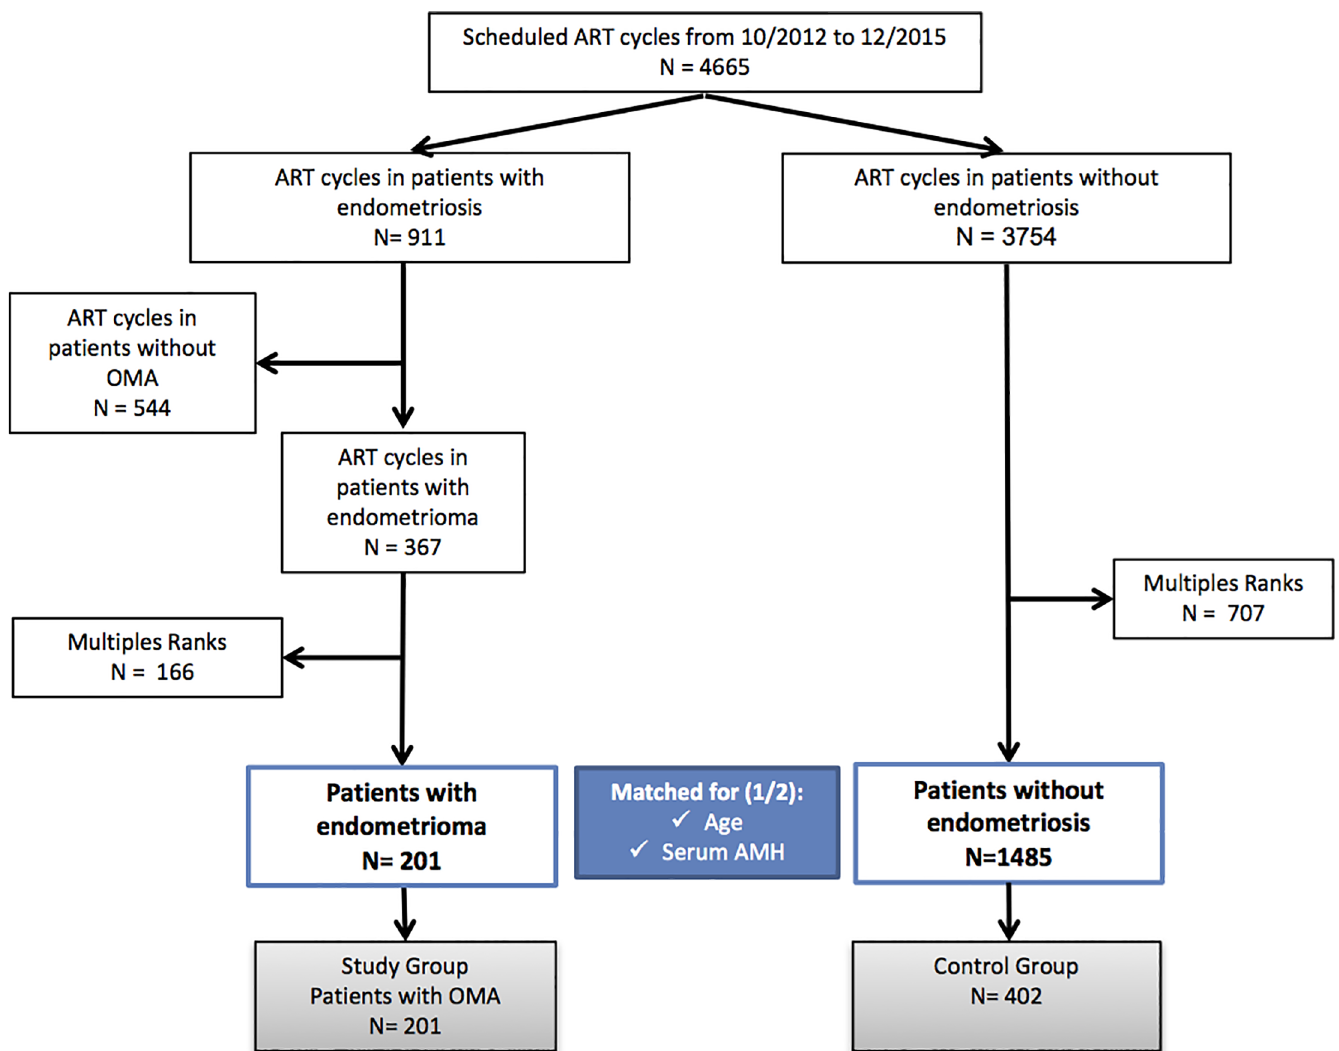
Fig 1. Patient inclusion flowchart. OMA: Ovarian endometrioma; ART: Assisted reproductive technology; AMH: anti-Mu¨llerian hormone.